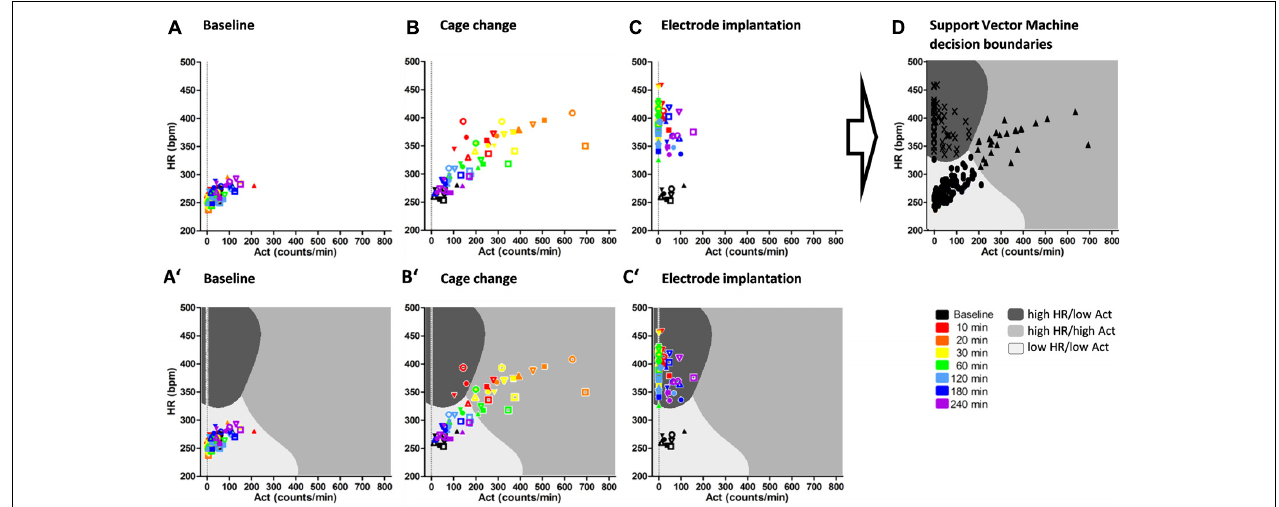
FIGURE 2 | Development of classification model in SD rats. Heart rate (HR; bpm) and activity (Act; counts/min) until 4 h after experimental procedures of baseline as no stress (A) , cage change as stress-like response inducing procedure (B) , and electrode implantation as distress (C) . (A–C) served as training data set for development of Support Vector Machine (SVM) decision boundaries map (D) with blinded training data set (black symbols). SVM identified three classes: dark gray: high HR/low Act, midgray: high HR/high Act, light gray: low HR/low Act. Overlay of training data and decision boundaries (A’–C’) . HR is shown as mean, and Act is shown as sum over 10 min starting at the indicated time points (color-coded). Symbols indicate different